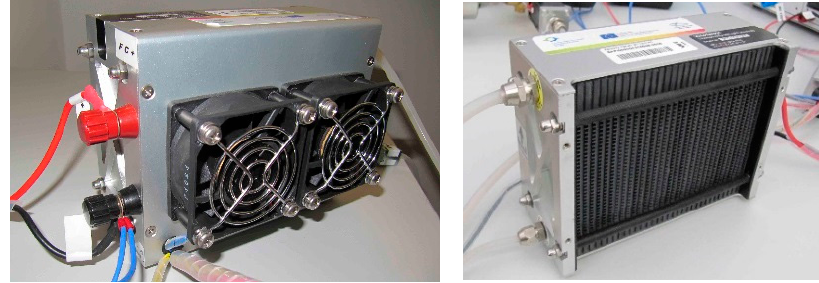
Figure 2. The H-200 FC Stack by Horizon FC Technologies (left- and right-hand side).